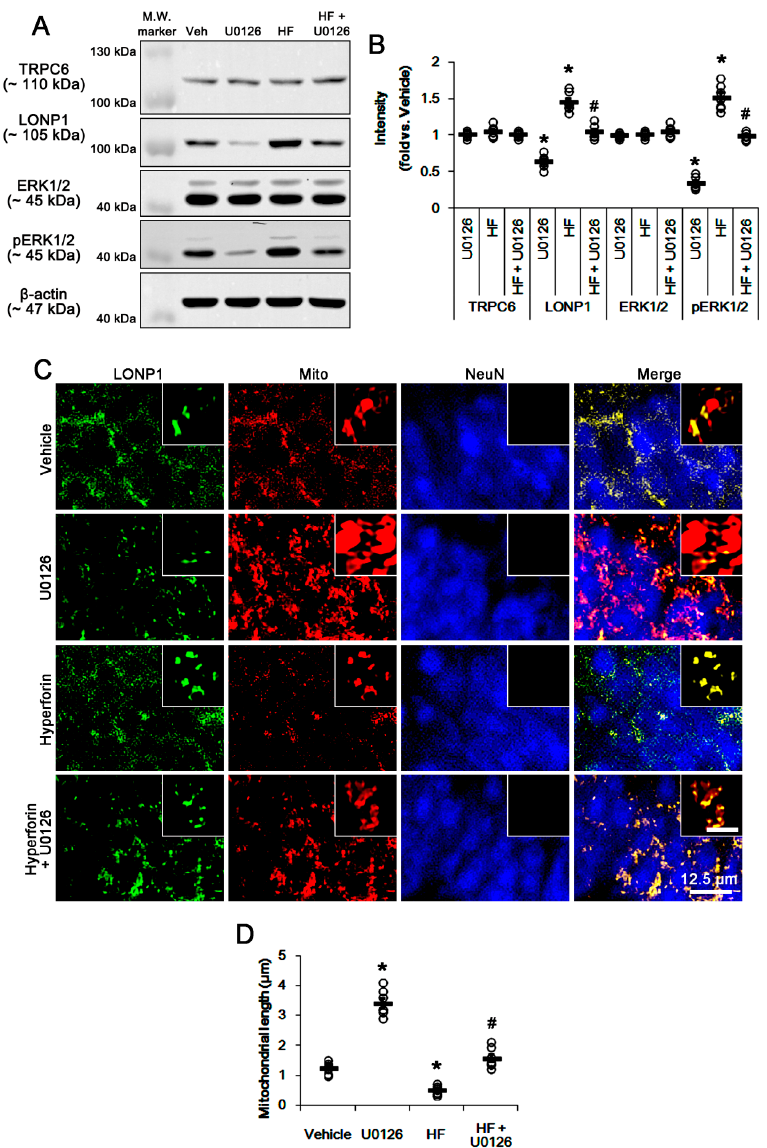
Figure 3. Effects of U0126, hyperforin, and co-treatment of hyperforin and U0126 on expression levels of LONP1 and TRPC6, ERK1 / 2 phosphorylation and mitochondrial dynamics under physiological condition. ( A , B ) Effects of U0126, hyperforin (HF) and co-treatment of hyperforin and U0126 (HF + U0126)